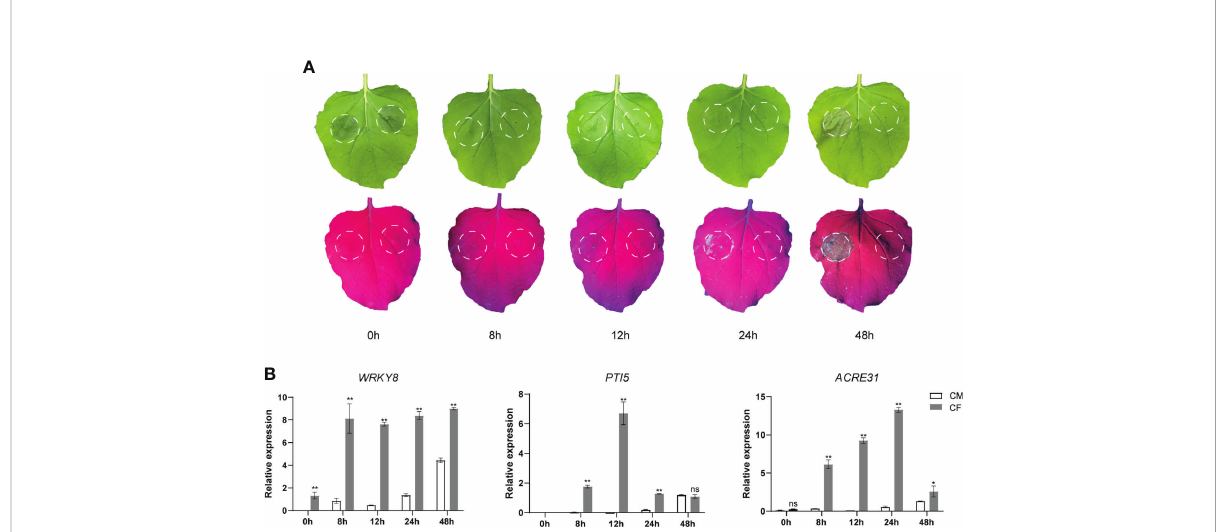
FIGURE 1 The culture fi ltrate (CF) of Phytophthora infestans induced PAMP triggered immunity responses in Nicotiana benthamiana. (A) CF was in fi ltrated within a white line circle on the left panel of the mid vein while culture medium (CM) was on the right panel. (B) CF-induced upregulation of PTI marker genes WRKY8 , PTI5 and ACRE31. Independent experiments have been conducted three times with similar results. Student ’ s t -test was used for the statistical analysis. Error bars stand for SEM, ns, not signi fi cant, * P < 0.05 and ** P <